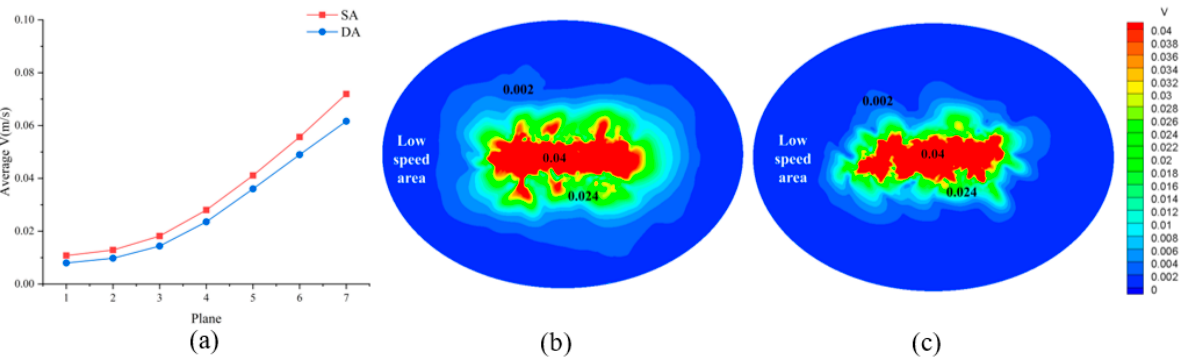
Figure 9. Average velocity and velocity distribution of 7 planes: ( a ) Average velocity of 7 planes; ( b ) SA on plane 4 velocity distribution; ( c ) DA on plane 4 velocity distribution.